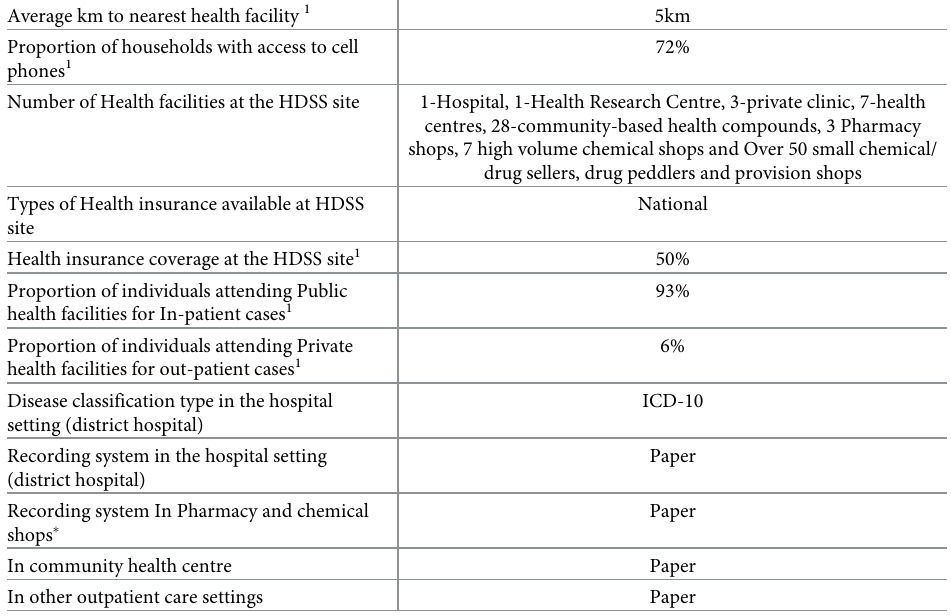
Table 1. Characteristics of the study